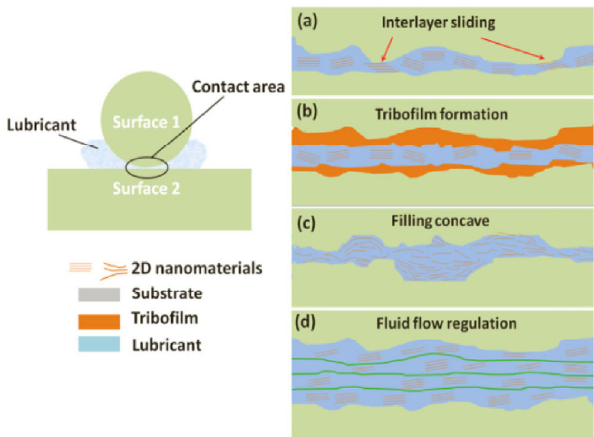
Fig. 8 Lubrication mechanisms of 2D materials. (a) entering the contact area of sliding surfaces, (b) tribofilm formation, (c) filling the pits and gaps of the contact area, (d) affecting the fluid drag and viscosity. Reproduced with permission from Ref. [106], © Elsevier